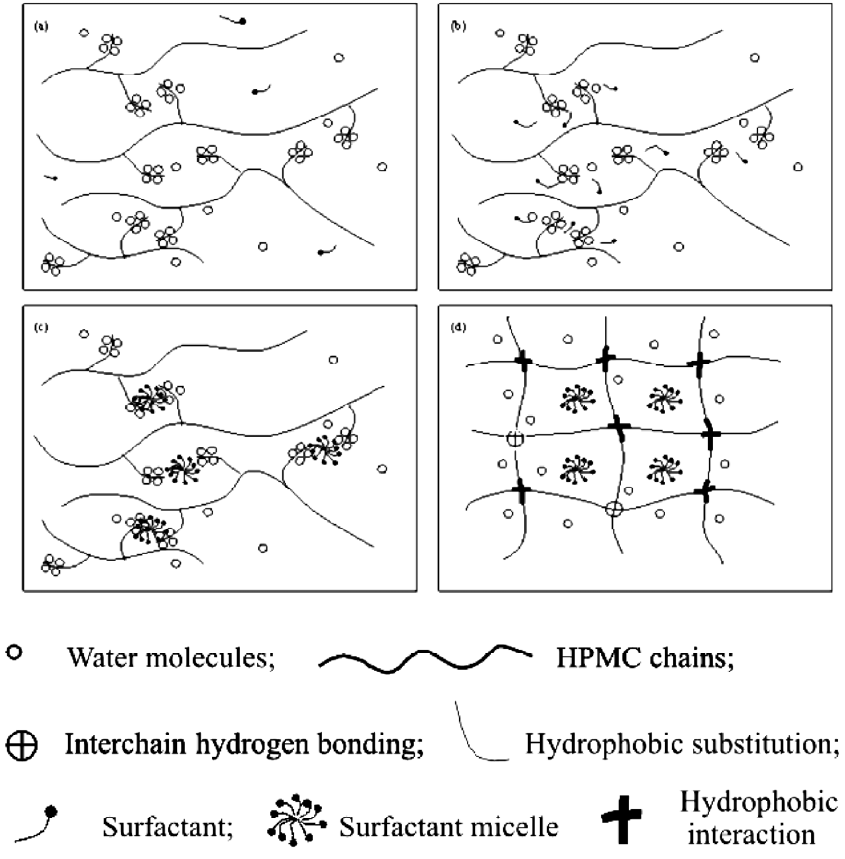
Figure 8. Schematic diagram showing interaction between HPMC and SDS: ( a ) SDS concentration lower than 6 mM; ( b ) SDS concentration between 6 and 8 mM; ( c ) SDS concentration higher than 8 mM; ( d ) the final network structure of HPMC